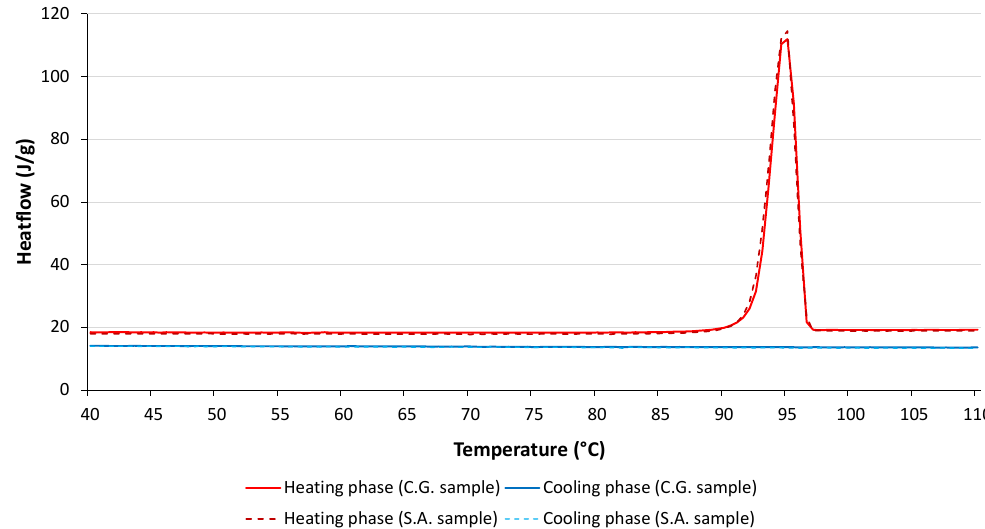
Figure 1. DSC analysis of commercial-grade xylitol (C.G. sample) and pure xylitol from Sigma Aldrich (S.A.